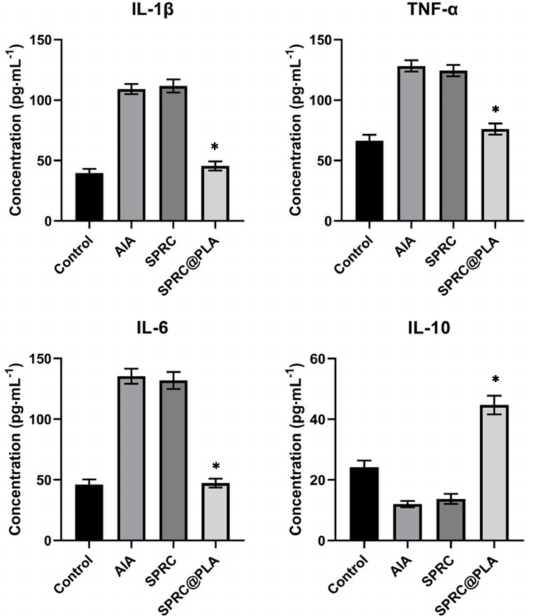
Figure 8. The pro-inflammatory cytokine levels of IL-1 β , TNF- α , and IL-6, and anti-inflammatory cytokine level of IL-10 in rats were measured. * indicated a significant different as compared with the AIA model group ( n = 5, mean ±